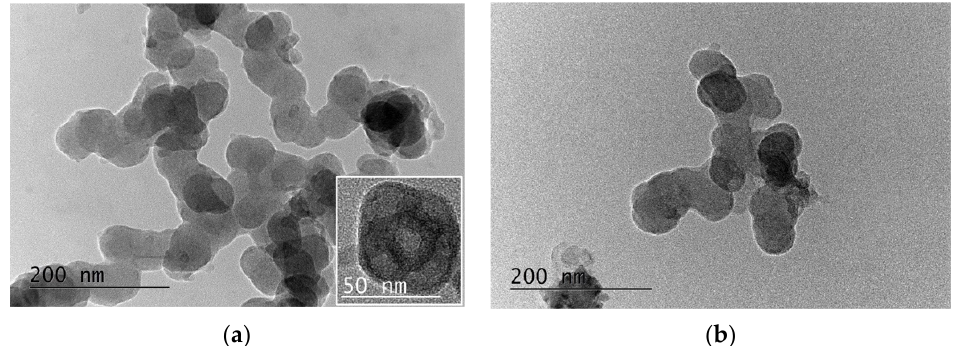
Figure 5. TEM micrographs of: ( a ) empty micelles (d = 55.93 ± 5.68 nm); ( b ) curcumin-loaded micelles (d = 63.32 ± 4.75 nm), obtained from the amphiphilic triblock copolymer T2-1.